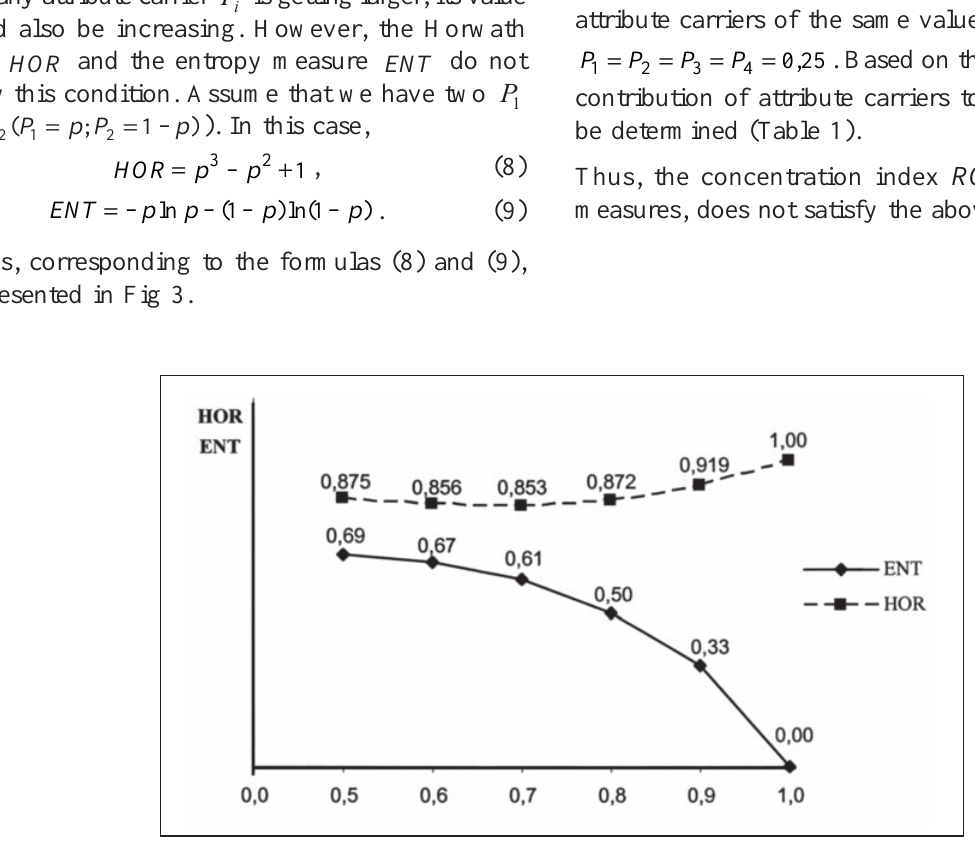
Fig 3. Graphical representation of the Horwath and concentration indices as well as entropy measure,